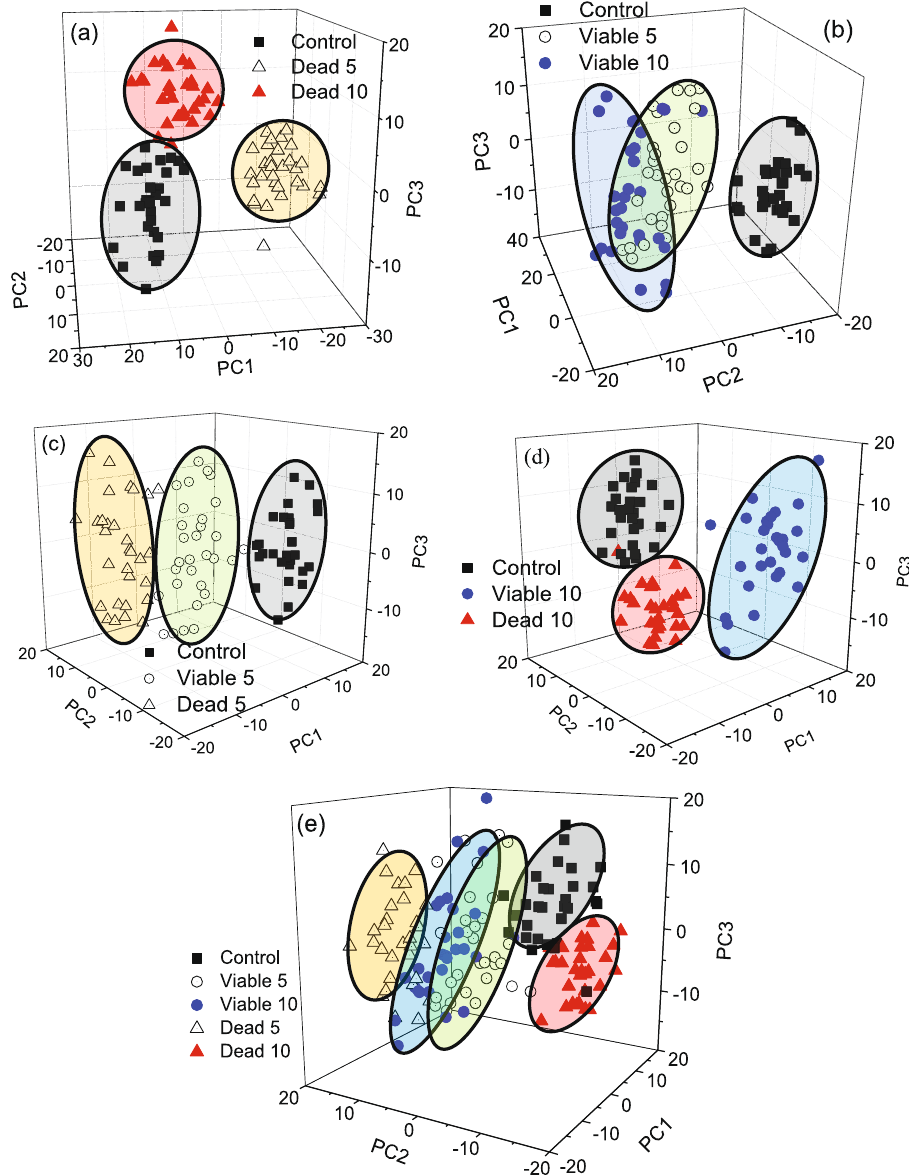
Figure 6. PCA scatter plots of the 4T1 breast cancer cells groups: control and dead ( a ), control and viable ( b ), control and treated with NE/PS5 ( c ), and control and treated with NE/PS10 ( d ). A comparison among all five cells groups is shown in ( e